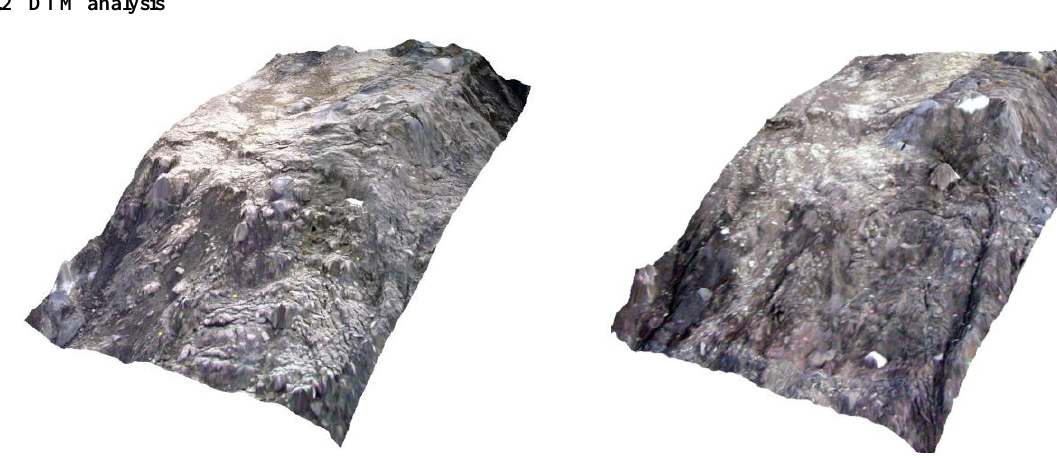
Figure 11. DTM of the upper part of the Super-Sauze landslide in October 2009